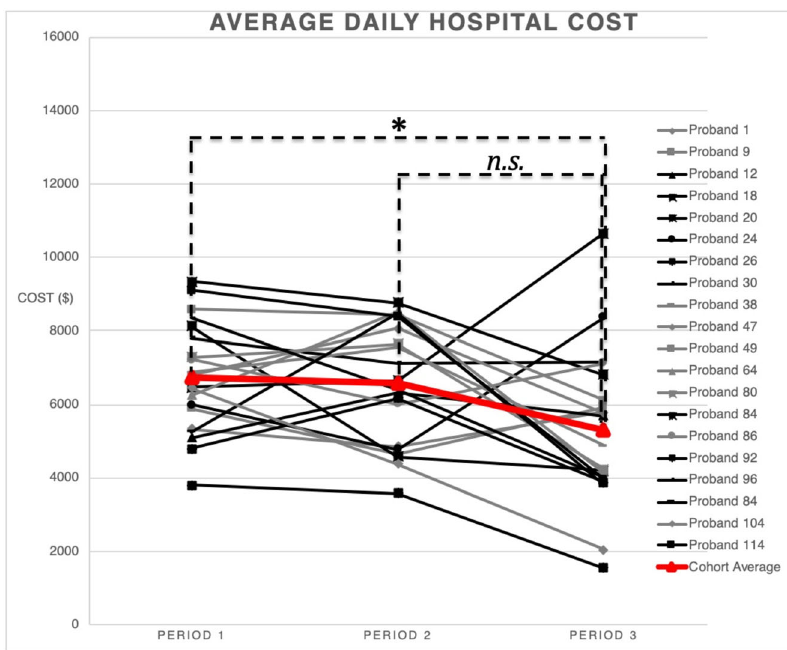
Fig. 4 Average daily hospital cost per tercile of hospitalization. Total Hospital cost was divided in three equal parts and the average daily hospital costs calculated (Supplementary Table 2c). There is a signi fi cant association between time period and cost ( p = 0.047; repeated measures ANOVA). There was statistically signi fi cant decrease in average daily hospital cost from the fi rst third of the hospitalization compared to the last third ( p = 0.036, mean difference 1438.53, SE 518.81, 95% CI 76.60 – 2800.47), but there was no statistically signi fi cant decrease when comparing the fi rst third of the hospitalization with the second third ( p = 1, mean difference 178.22, SE 352.18, 95% CI − 746.30 to 1102.73) or the second third with the last third ( p = 0.1, mean difference 1260.32, SE 551.59, 95% CI − 187.66 to 2708.30 ; repeated measures ANOVA with Bonferroni